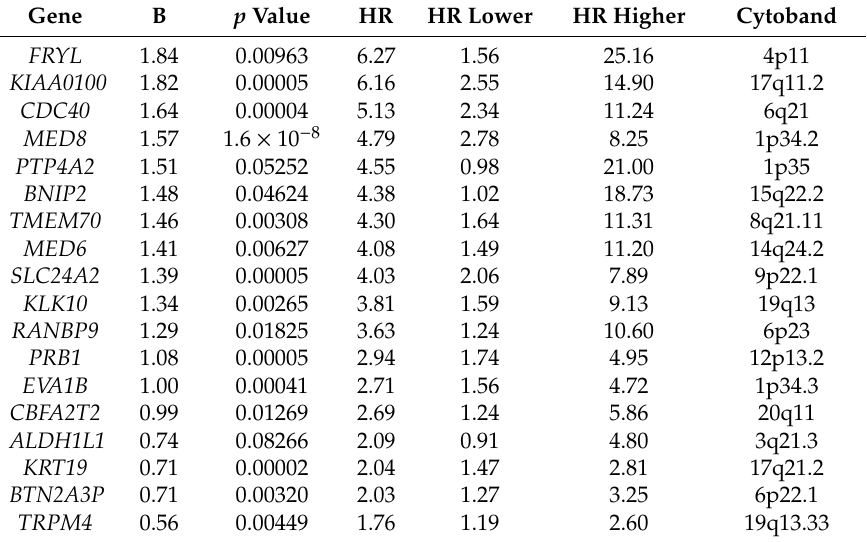
Table 5. Genes associated to poor prognosis in the multivariate Cox survival